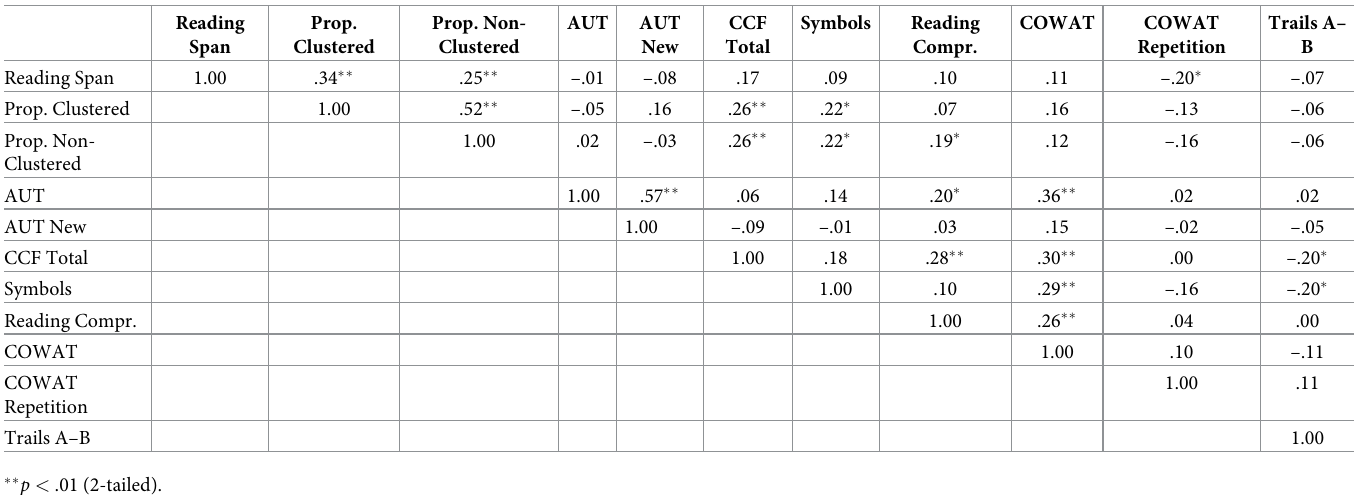
Table 6. Pearson correlations between measures employed in Study 2. Reading